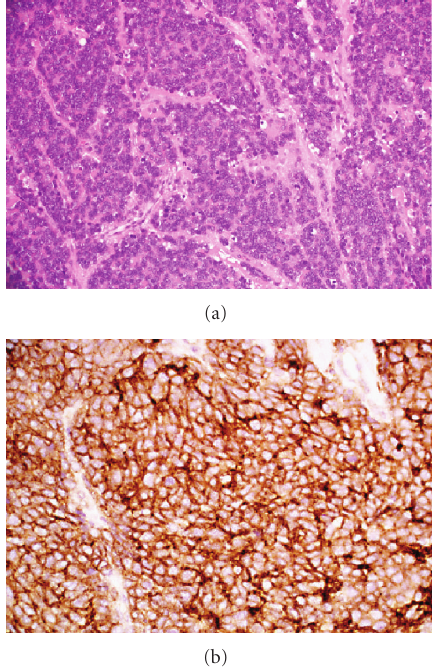
Figure 3: Histopathology of a nephrectomy specimen: haema- toxylin and eosin stain, showing tumor composed of sheets of small round cells with uniform round nuclei and scanty cytoplasm ( × 200). Immunohistochemistry showing di ff use membranous pos- itivity of cells for CD99 ( ×